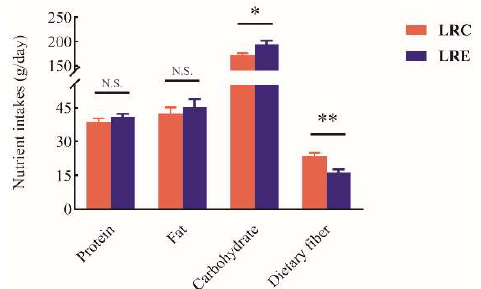
Figure 7. Macronutrient and dietary fiber intakes in the LRC group and LRE group. Data are shown as mean ± SEM. Asterisks designate significance by student t -test. * p < 0.05, ** p < 0.01. N.S. denotes that there is no significant difference between the two groups. The dietary fiber intake of the LRC group was significantly higher than that of the LRE group ( p < 0.01). Meanwhile, the carbohydrate intake of the LRC group was significantly lower than that of the LRE group ( p < 0.05). LRC, centenarians in the longevous region; LRE, elderly people aged 60–70 years in the longevous region. Table 5. Energy intake and macronutrients-calorie percent composition.